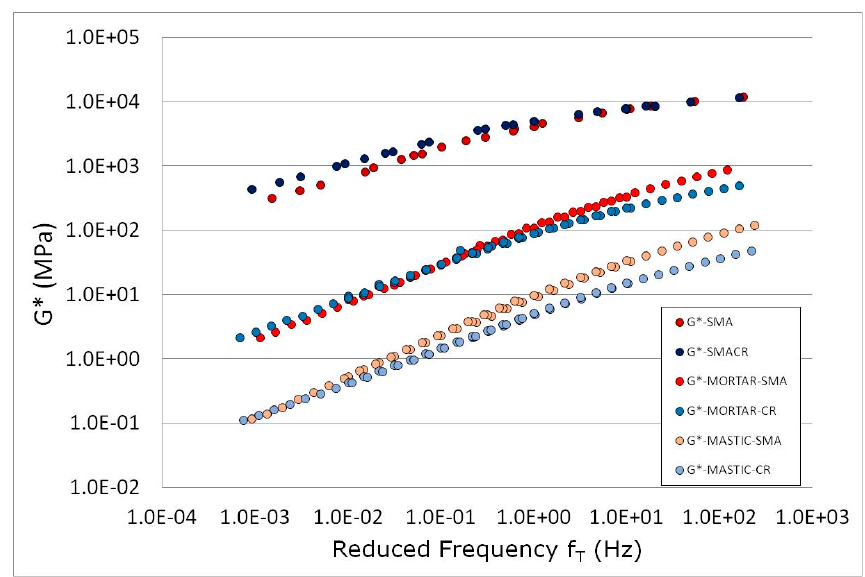
Figure 12. Master curves comparison between mixture, mortar and mastic containing CR or not.